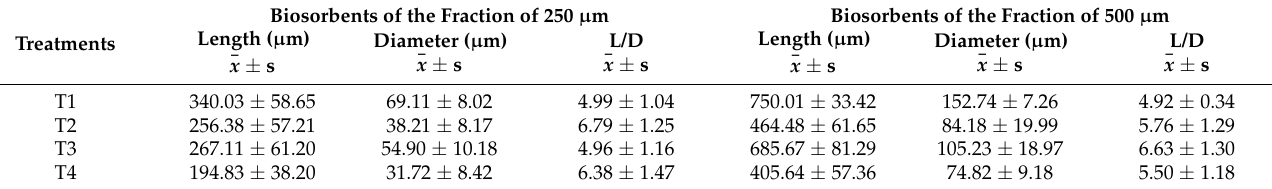
Table 6. Measurements of the modified biosorbents obtained.